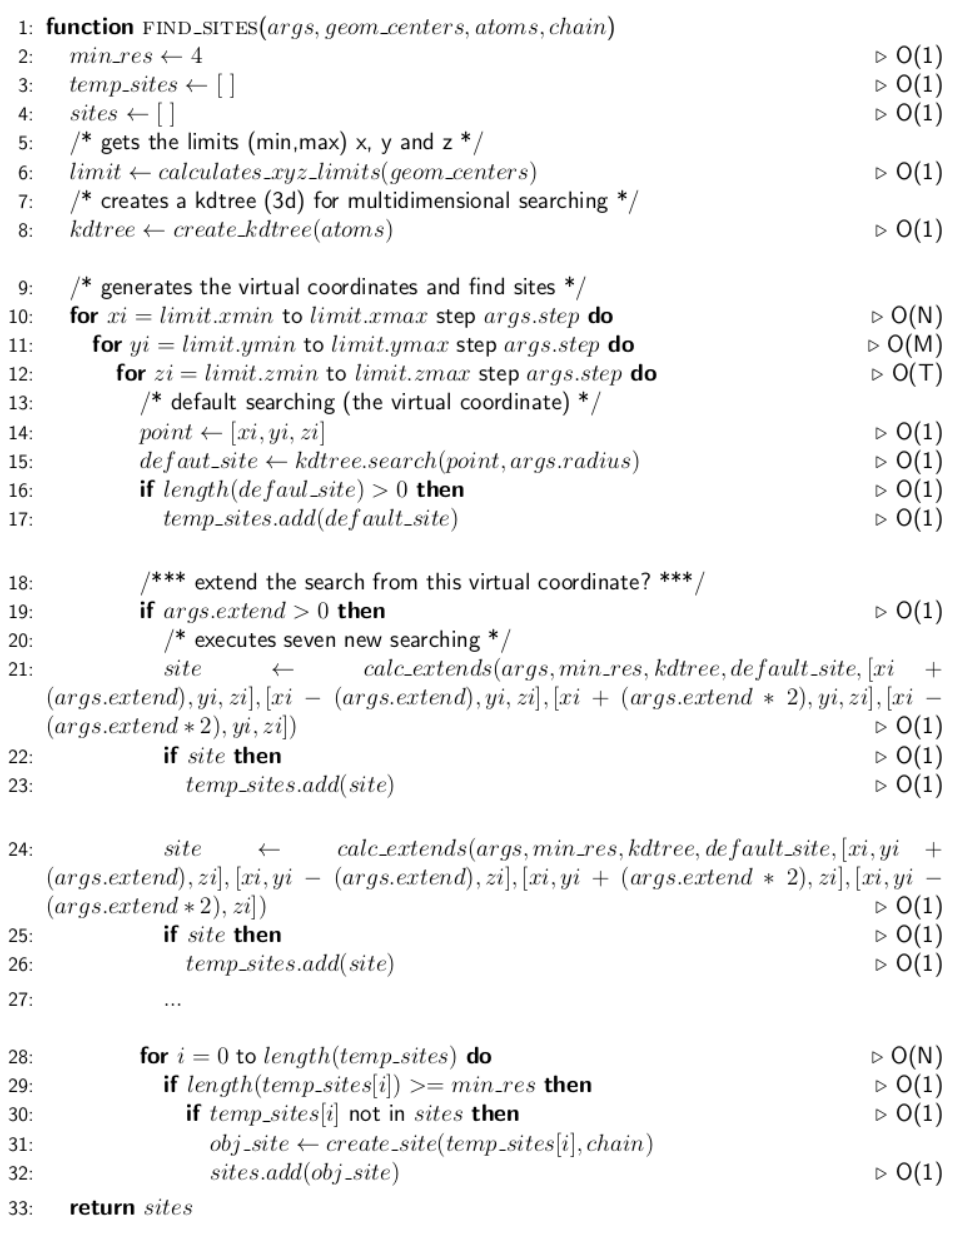
Figure 8. Pseudocode of the FIND_SITES function of 3D-PP. Figure 8 shows the pseudocode of the function for the searching of 3D-patterns without any previous knowledge about the ligands or binding sites in the protein structures. On each line of the algorithm is indicated the computational